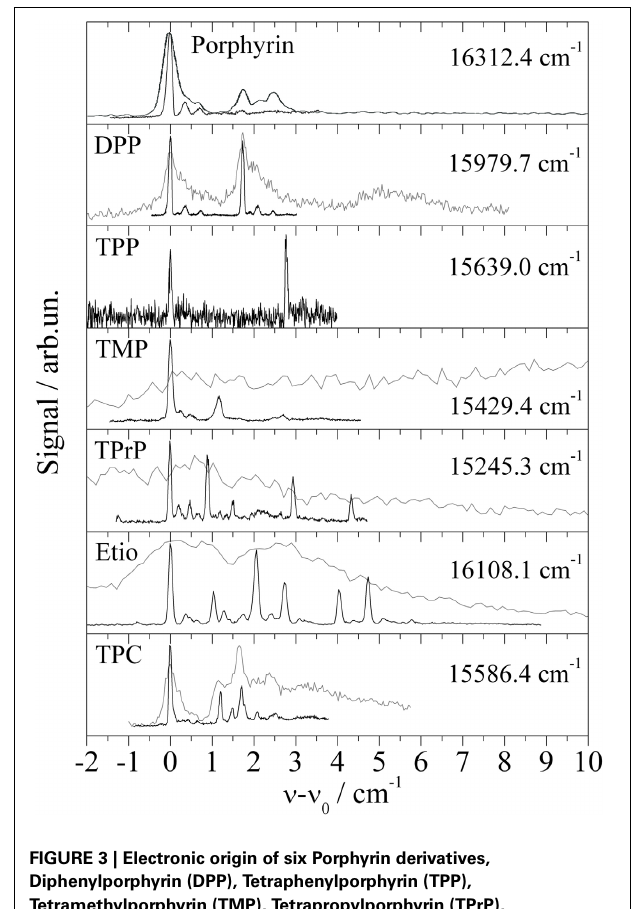
FIGURE 2 | Fluorescence excitation spectrum of four Pyrromethene drivatives in helium droplets (black and red). For comparison the supersonic jet spectra are added in gray corrected for the helium solvation shift. Extended low energy progressions are damped in helium droplets ( left panel ) while the electronic origin is not ( right panel ).